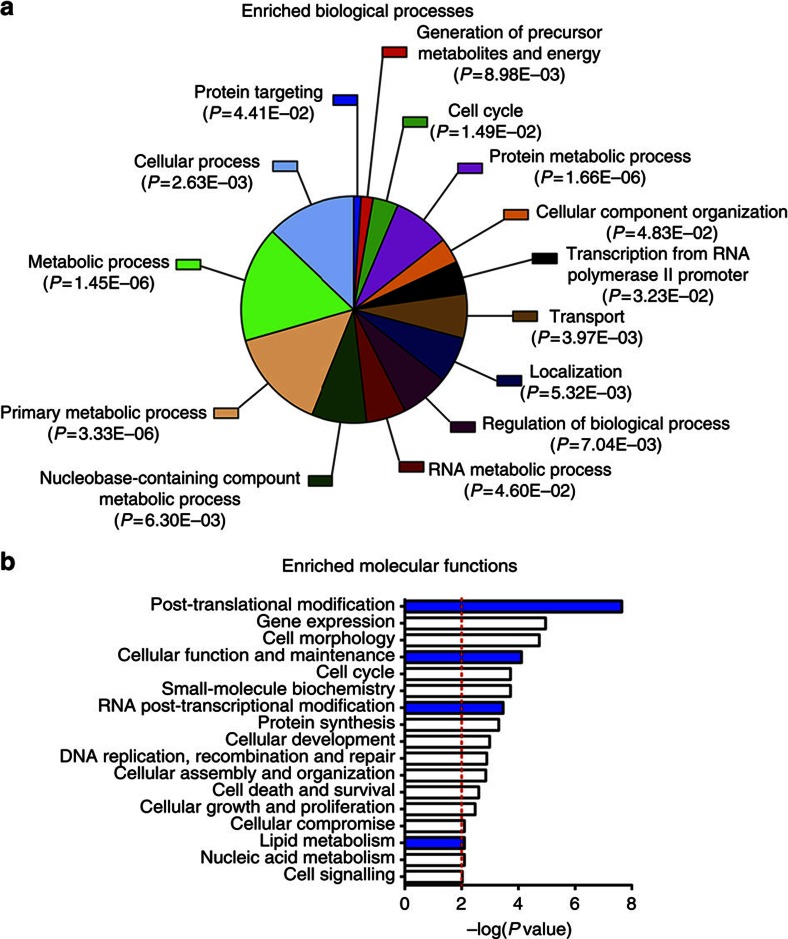
Screening results analysis.(a,b) PANTHER (http://www.pantherdb.org/) and Ingenuity (www.ingenuity.com) gene ontology (GO) analysis for enrichment of certain categories in the context of biological processes or molecular functions, respectively. See Supplementary Fig. 2 for a graphical illustration of some pathways included in the GO terms labelled in blue in b.